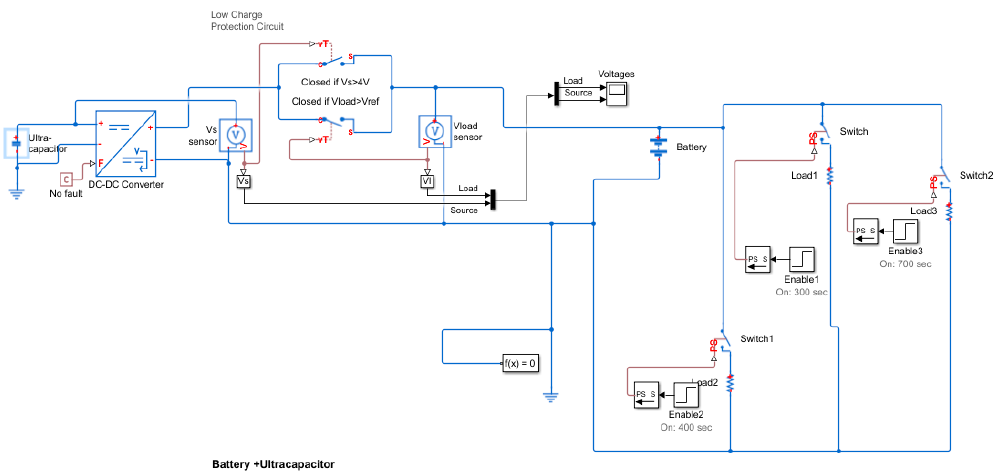
Figure 12. Simulink model of energy management system.